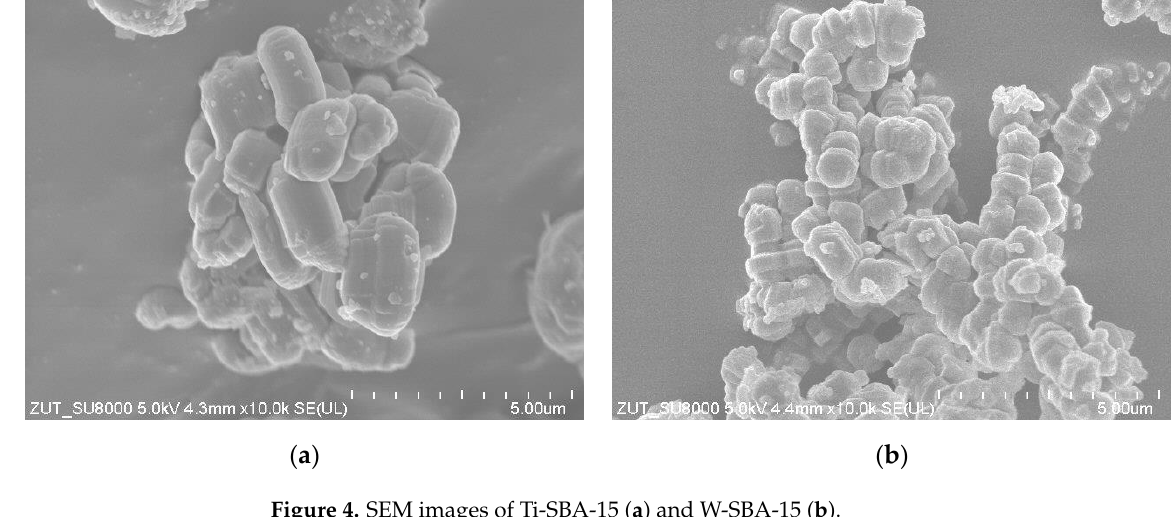
Figure 4. SEM images of Ti-SBA-15 ( a ) and W-SBA-15 ( b ).